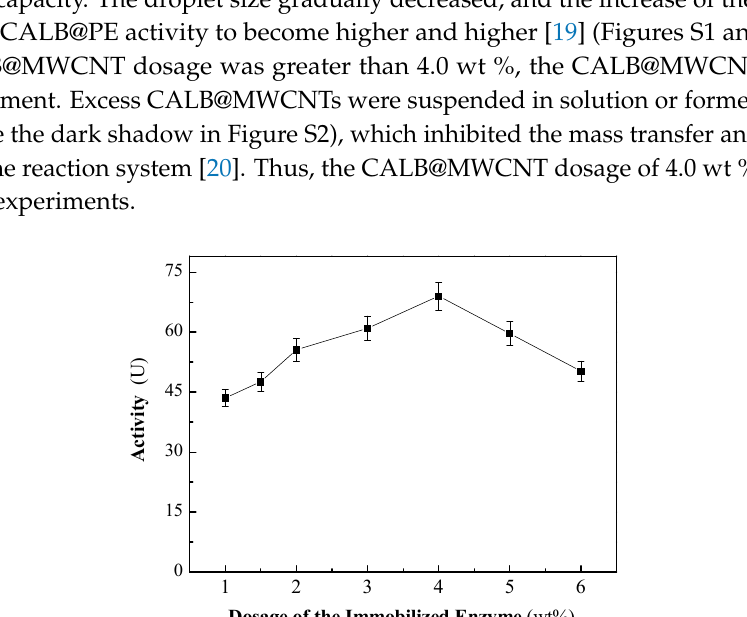
Figure 1. Effect of multiwalled carbon nanotube-immobilized Candida antarctica lipase B (CALB@MWCNT) dosage on CALB Pickering emulsion (CALB@PE) activity.